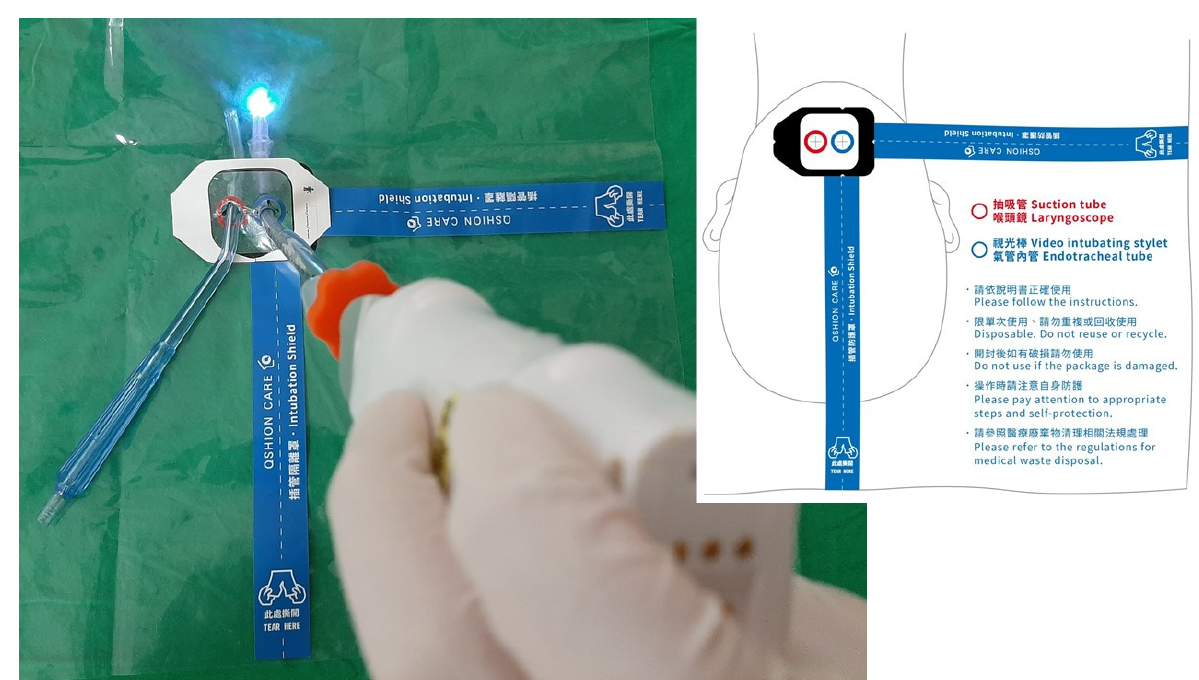
Figure 14. Prefabricated plastic sheet with areas marked by circles to guide creation of incisions for introduction of laryngoscope/suction catheter and video stylet/endotracheal tube, as well as seam lines to allow easy removal of the plastic sheet after intubation.